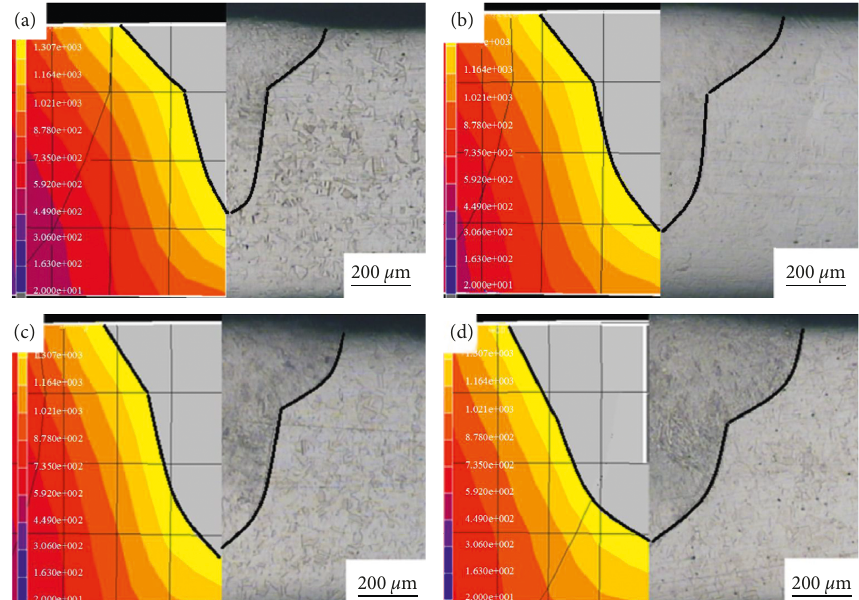
Figure 13: The comparison of experimental and simulation results of the weld profile for different welding speeds in surfacing welding: (a) 2 m/min, (b) 1.6 m/min, (c) 1.2m/min, and (d) 0.8m/min.